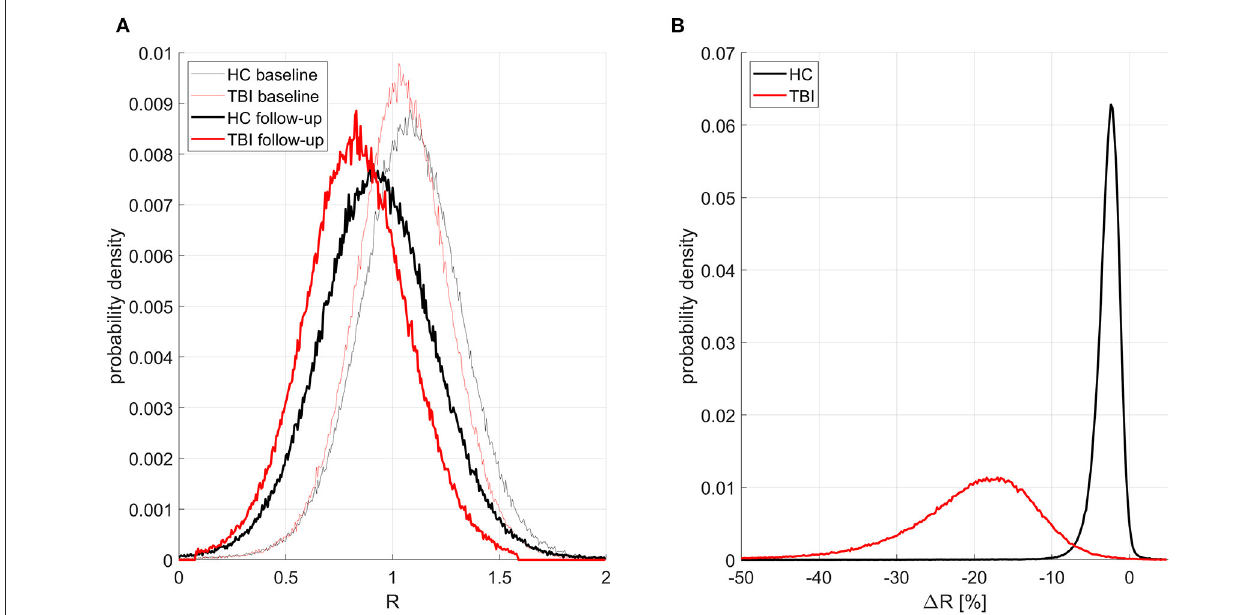
FIGURE 1 | Probability distribution functions (PDFs) of the confound-adjusted myelin ratio R across all cortical locations for all groups and study timepoints. Traces for HCs and mTBI participants are drawn in black and red, respectively. Thinner and thicker lines correspond to timepoints 1 and 2, respectively. (A) PDFs for subject averages of R across the cortex. As expected, at both timepoints, HCs have more myelin than mTBI participants, and there is more myelin at the first timepoint in each group. (B) PDFs of 1 R (percent change in R across timepoints) averaged across subjects. HCs have a much smaller relative decrease in myelin with time, with a relatively small standard deviation of 0.57% in the observed percentage change. By contrast, mTBI participants experience greater myelin loss, with a substantially larger standard deviation of